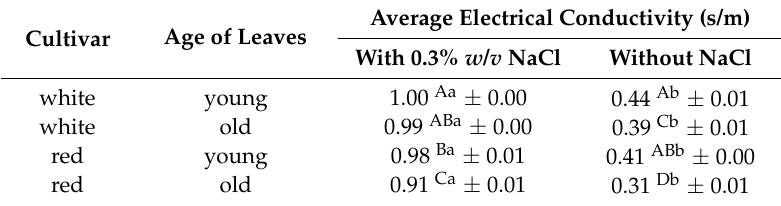
Table 1. Electrical conductivity of dried yacon leaves.